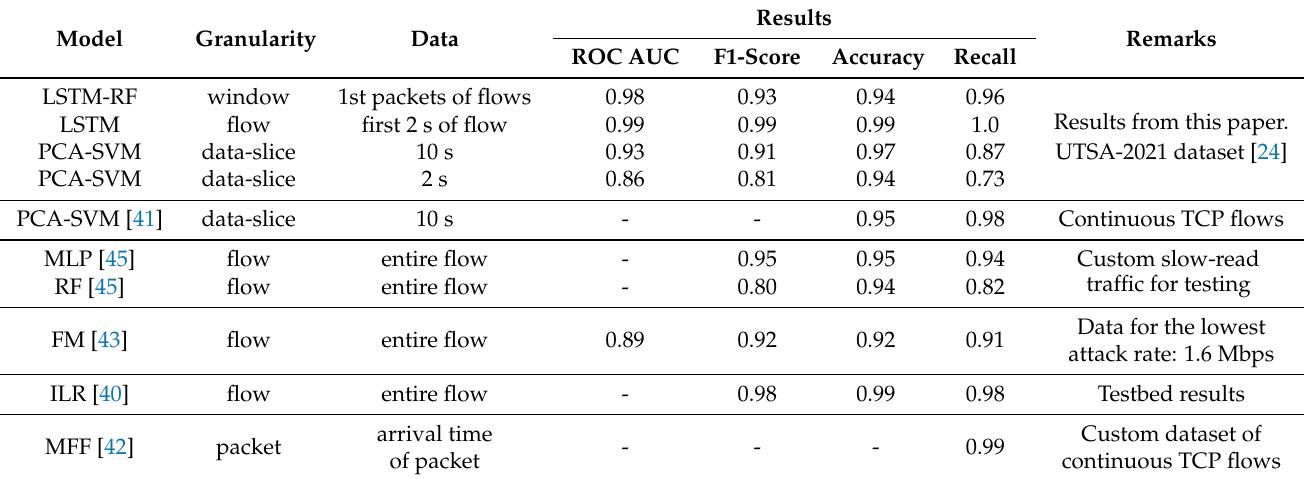
Table 5. Comparison of DL/ML-based LDDoS detection techniques. MLP: multilayer perceptron, FM: factorization machine, ILR: improved logistic regression, and MFF: multi-feature fusion. ‘-’: data not